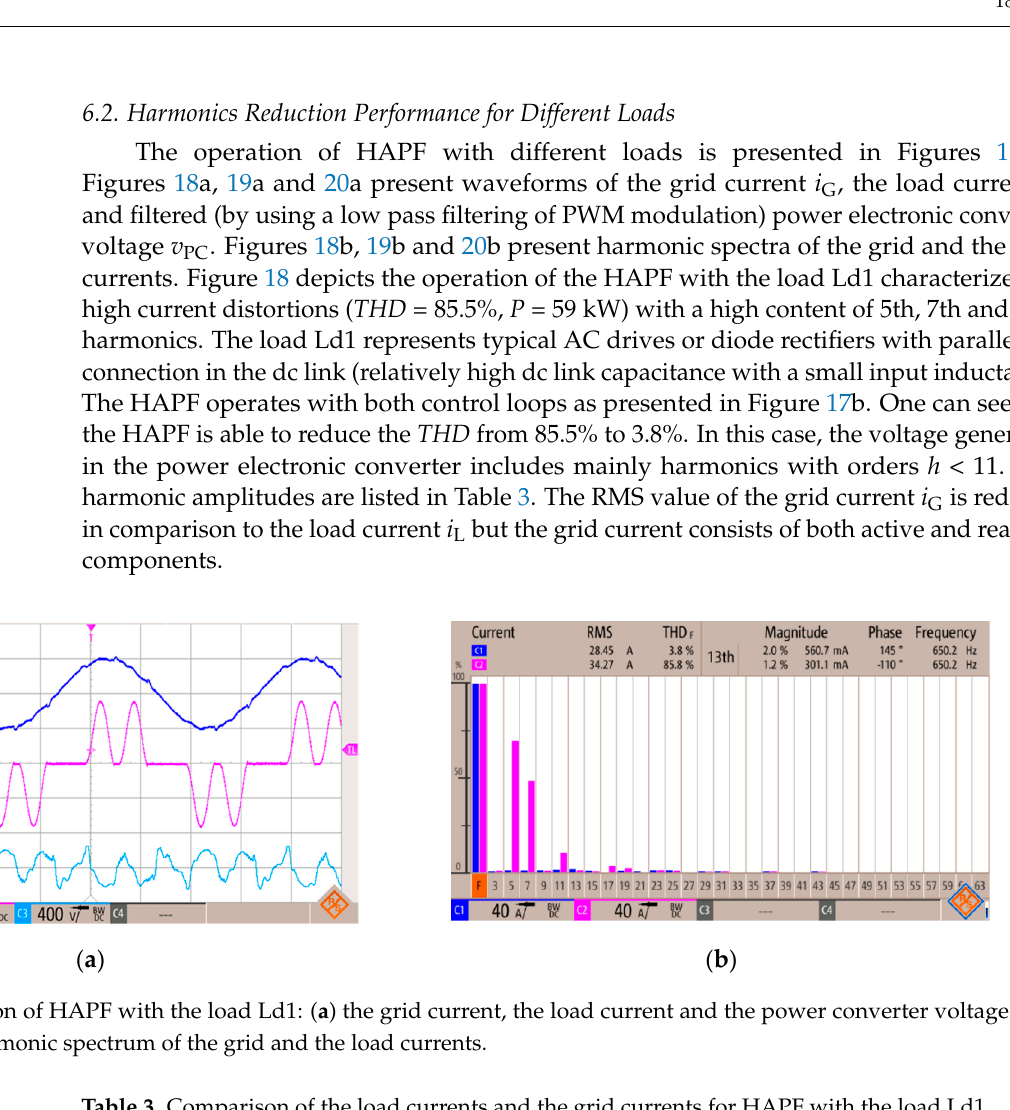
Figure 17. The effect of the time delay compensation on current waveforms and their spectra: ( a ) operation of HAPF without the time delay compensation; ( b ) operation of HAPF with the time delay compensation.